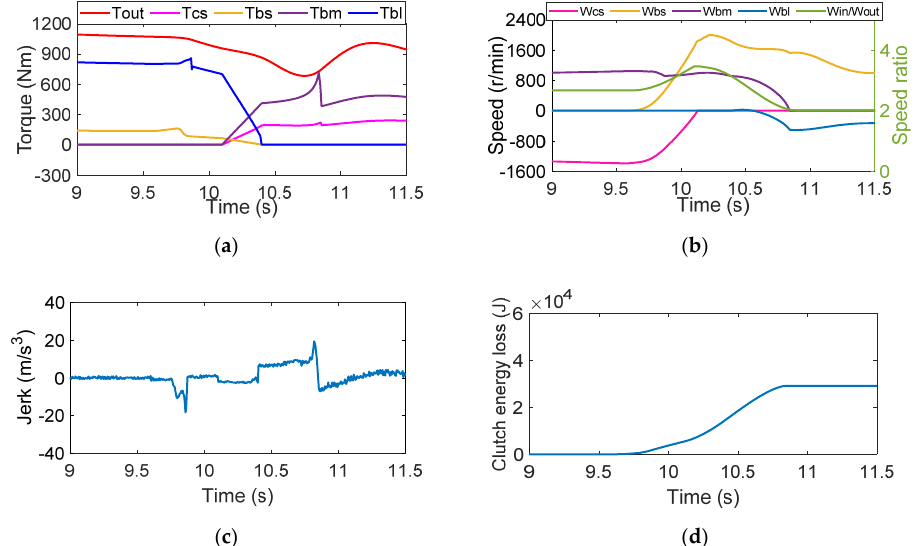
Figure 8. Simulation results of 2–3 power-on double-transition upshift for Strategy 4. ( a ) Output shaft and clutch torque. ( b ) Clutch speed and speed ratio. ( c ) The jerk of shift process. ( d ) The clutch energy loss of shift process.